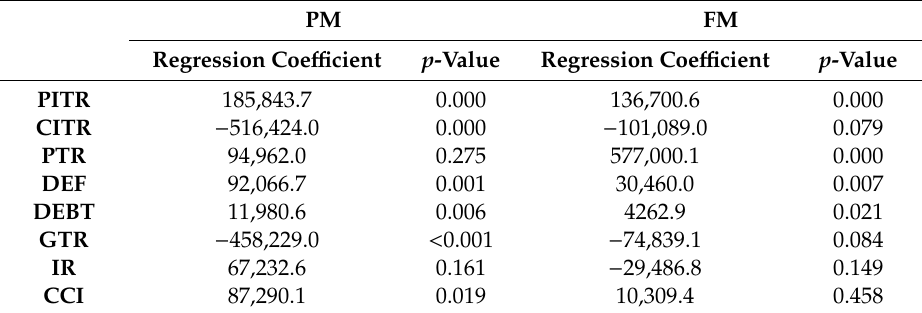
Table 2. Estimated models for the second group of